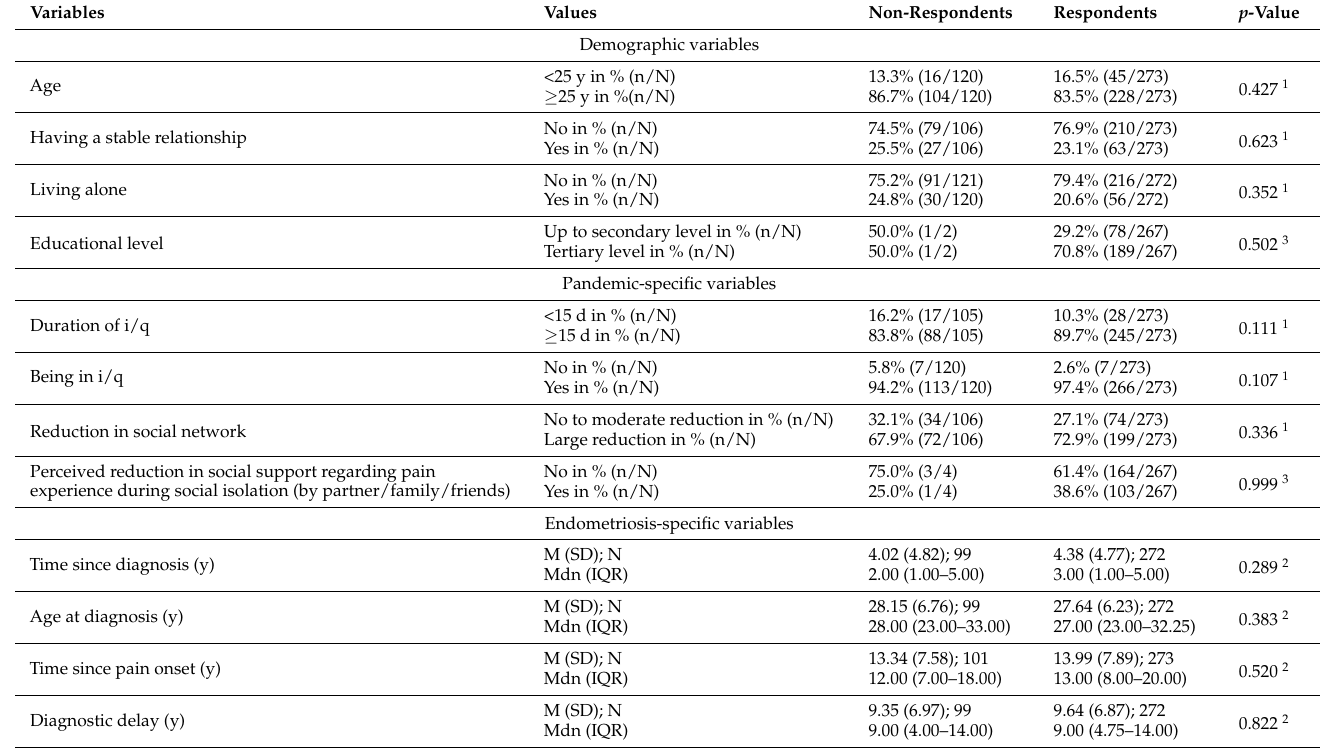
Table 1. Differences between participants who did not complete (group “Non-respondents”) versus those who completed the BRS questionnaire (group